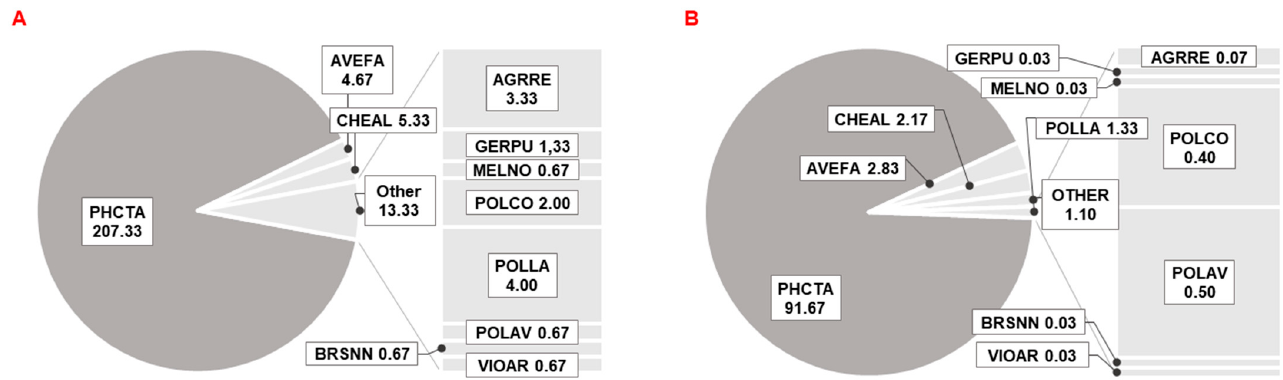
Figure A4. Number of plants per m 2 —Sowing 1 (5th of April) in 2019 ( A ) and leaf coverage in %—Sowing 1 (5th of April) in 2019 ( B ).